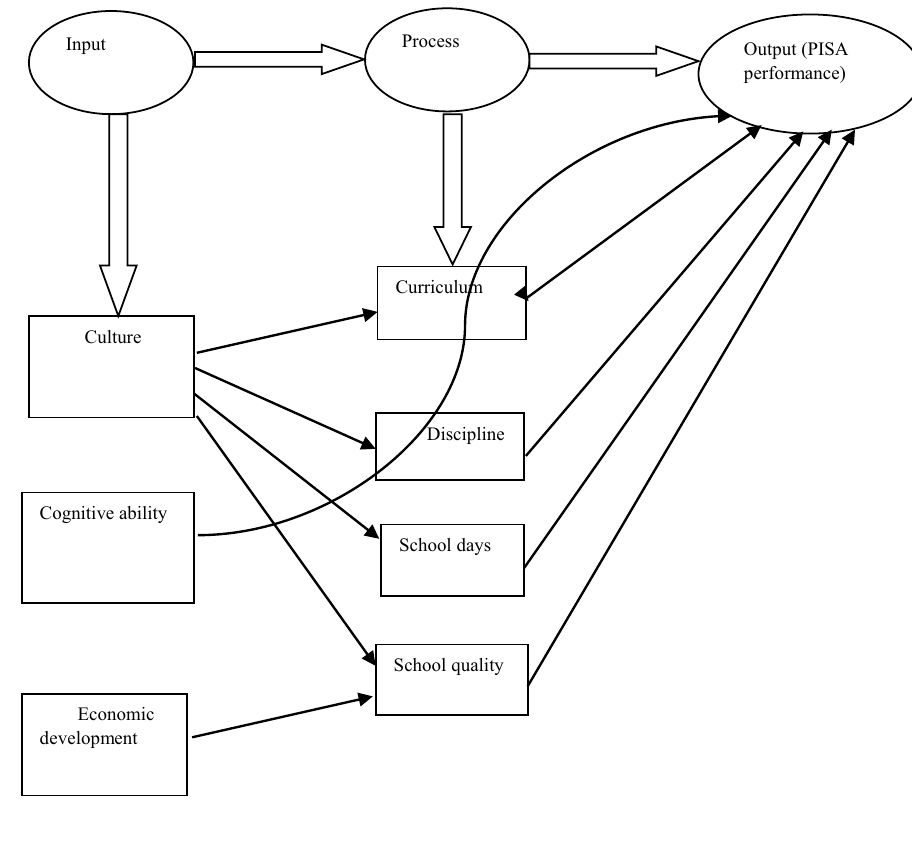
Fig. 2 Conceptual